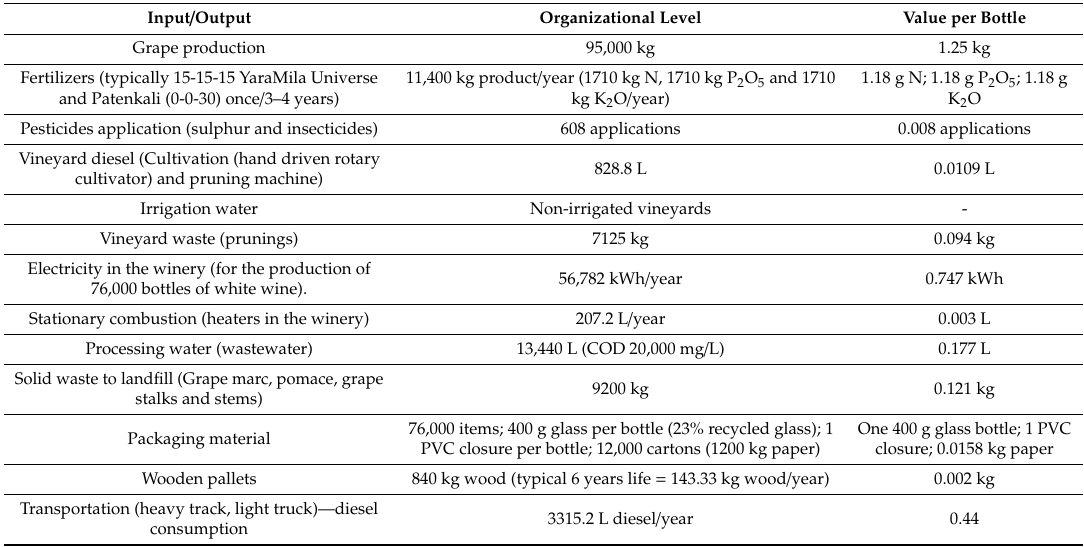
Table 1. Inventory for the inputs and outputs at the organizational level and per bottle of white wine produced from the variety